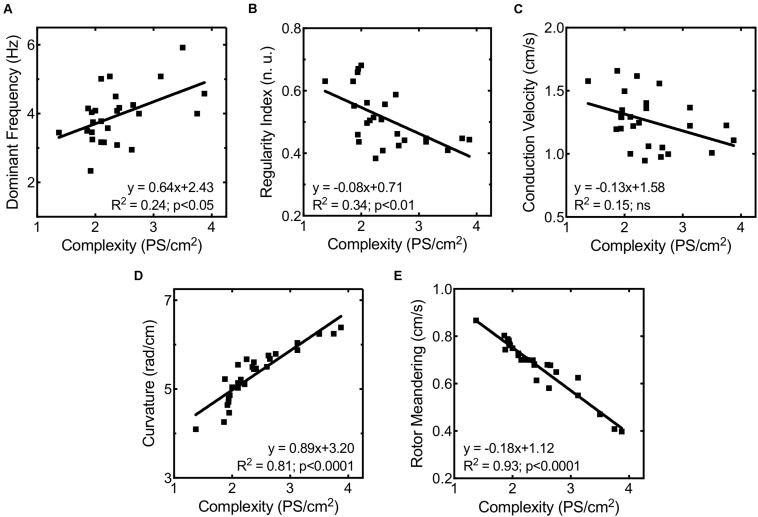
Correlation between fibrillation complexity and (A) highest dominant frequency, (B) maximum regularity index, (C) mean conduction velocity, (D) rotor curvature, and (E) rotor meandering.